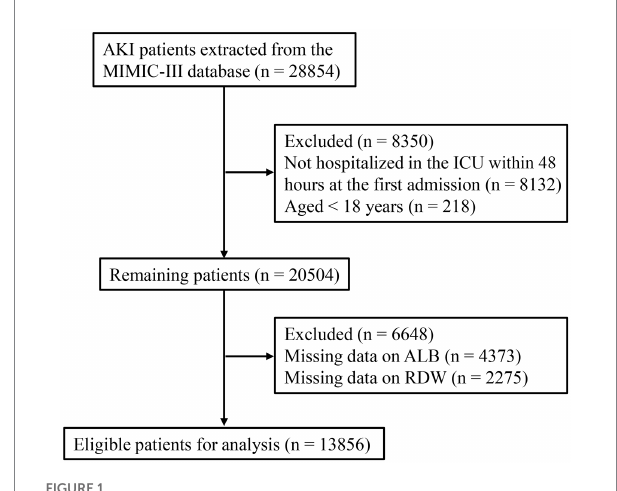
FIGURE 1 The flowchart of patients’